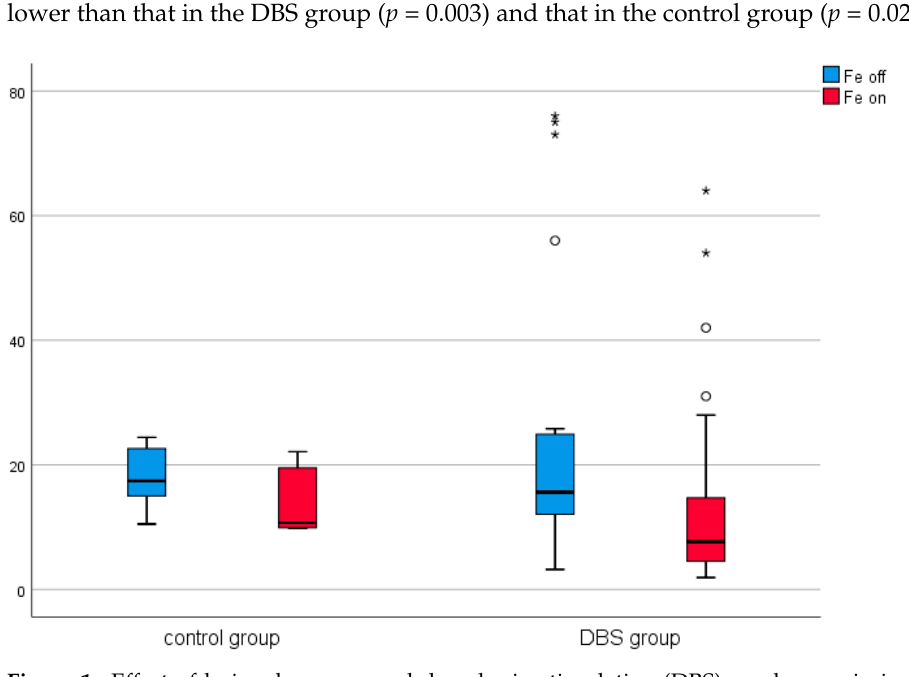
Figure 1. Effect of lesional surgery and deep brain stimulation (DBS) on changes in iron levels (µmol/L). (°—outliers ≦ 3SD, *—outliers > 3SD).